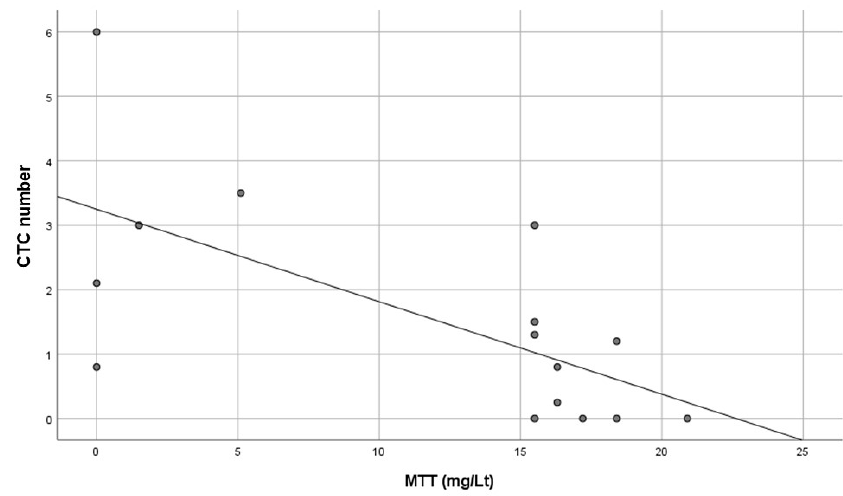
Figure 4. Association between mitotane (MTT) levels and CTC numbers evaluated in the same blood sample in three ACC patients receiving MTT only as post ‐ surgery chemotherapy. A statistically significant negative linear correlation was found between CTC number counted on ScreenCell device (ordinate) and MTT levels (abscissa); R = − 0.661, R 2 = 0.437, p = 0.007, n = 15.